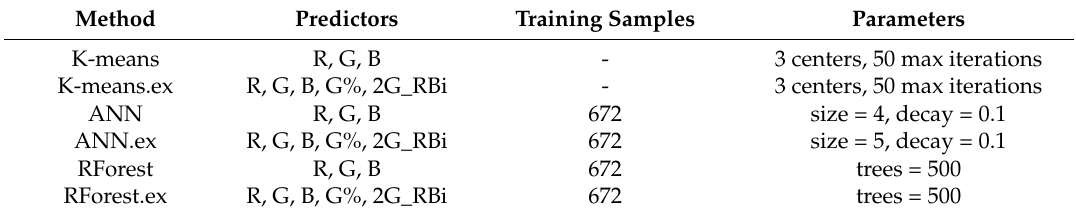
Table 2. Details of the predictors, training samples and parameters used in K-means, Artificial neural network, and Random Forest